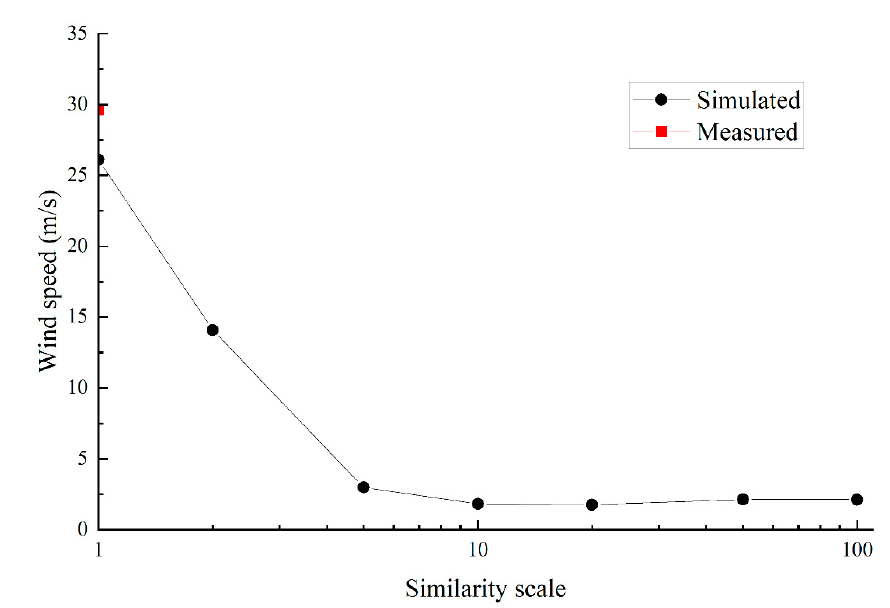
Figure 11. Stable atomization wind speed under different geometric scale conditions.